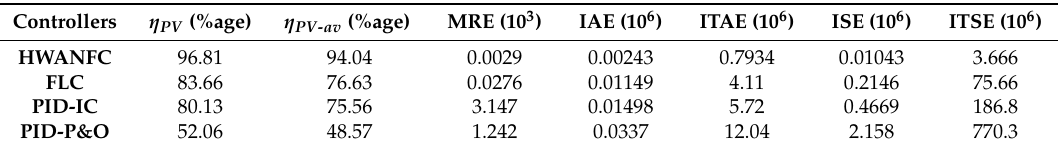
Table 2. PV efficiencies and performance parameters. FLC, Fuzzy Logic Controller; P&O, Perturb and